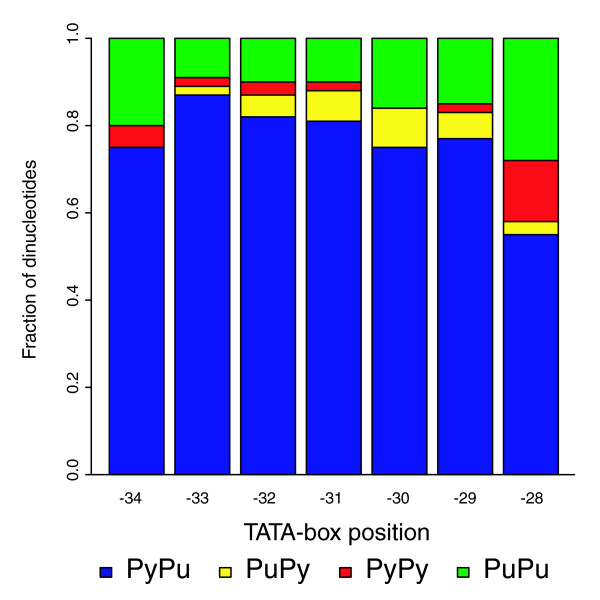
TATA-TSS spacing influences initiation site usage. Histogram showing the distribution of the four possible dinucleotides (PyPu, PyPy, PuPy, and PuPu) at the initiation site [-1, +1] for promoters with the TATA box located at each position in the -34 to -28 range. As described previously [8], initiation sites composed of PyPu dinucleotides are the most prominent, regardless of spacing. The dinucleotide distribution is significantly different for promoters where the TATA box starts at -28. Pu, purine; Py, pyrimidine.